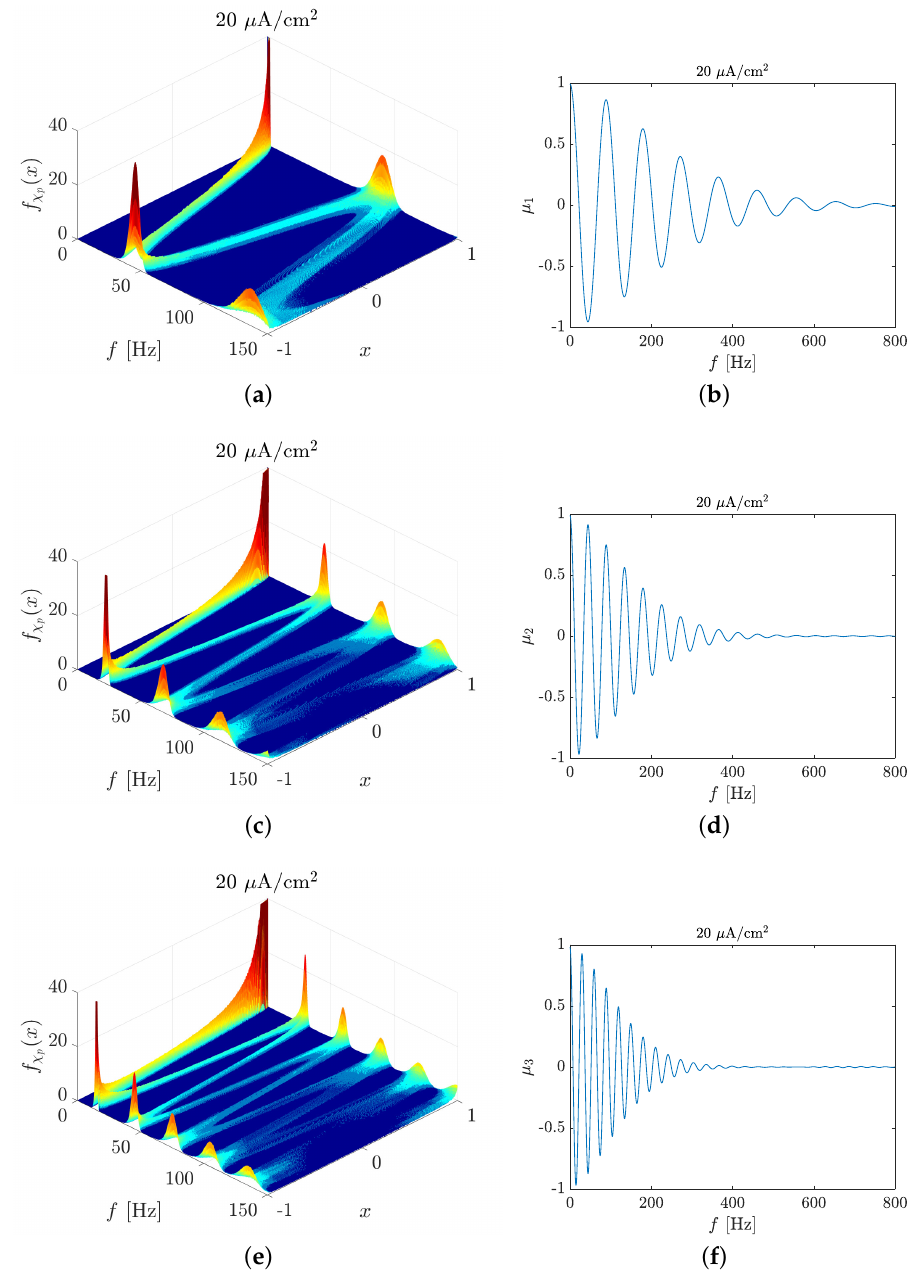
Figure 4. Probability density of χ p ( ω k ) are shown in panels ( a , c , e ) for p = 1, 2, and 3, respectively. µ p , expected value of χ p ( ω k ) , are shown in panels ( b , d , f ) for p = 1, 2, and 3, respectively. In all panels I 0 = 20 µAcm 2 , and patch = 100 µm 2